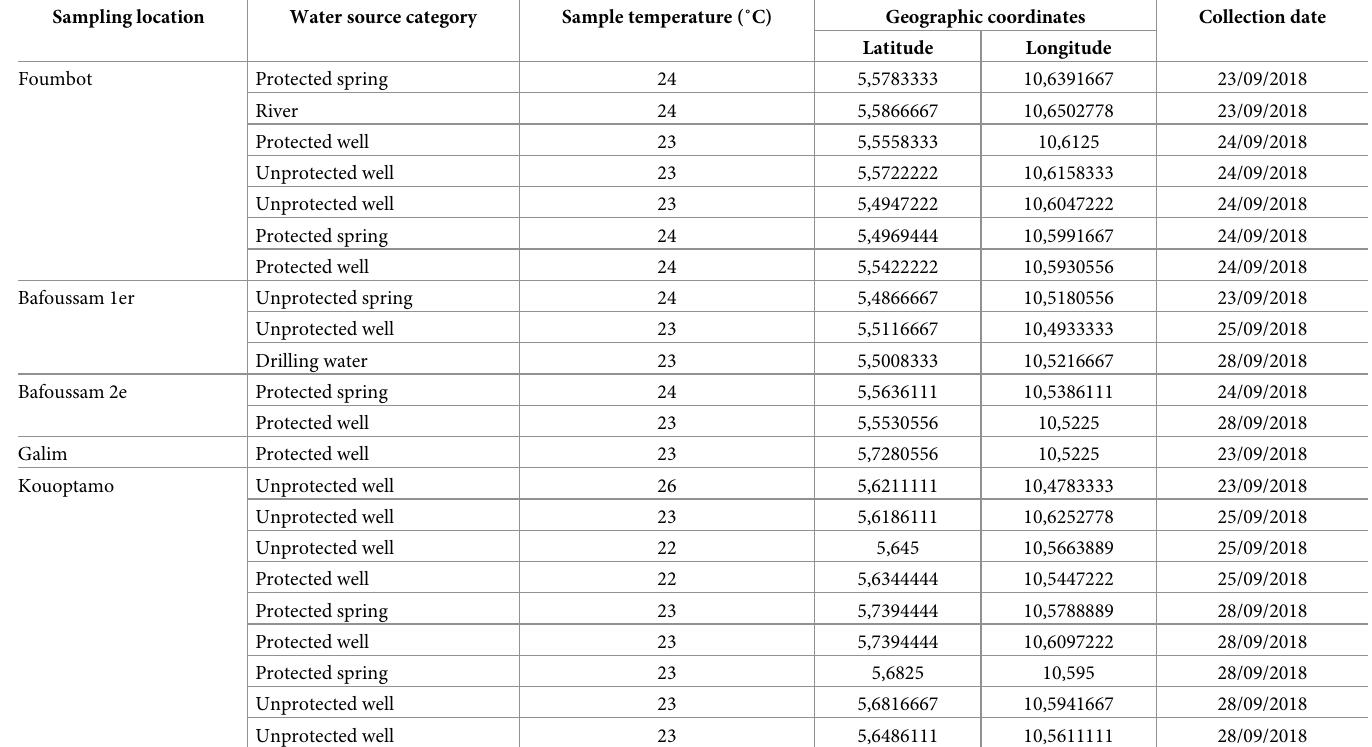
Table 1. Sampling locations, water sources categories, sample temperature (˚C), geographic coordinates, and samples collection dates. Sampling